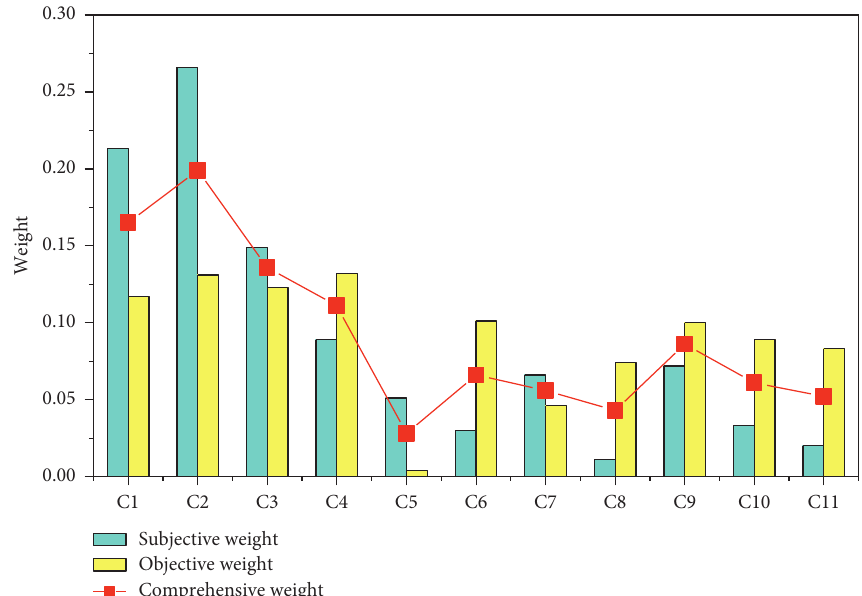
Figure 5: The risk assessment index is subjective, objective, and comprehensive